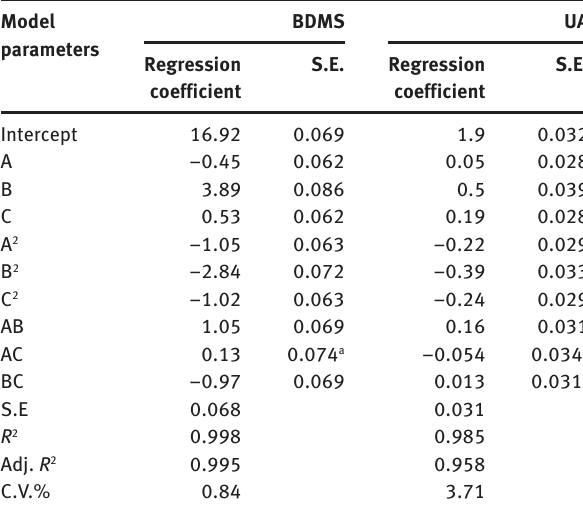
Table 3: Regression coefficients of the predicted second-order model for amount of β , β -dimethylacryl shikonin (BDMS) and ursolic acid (UA).